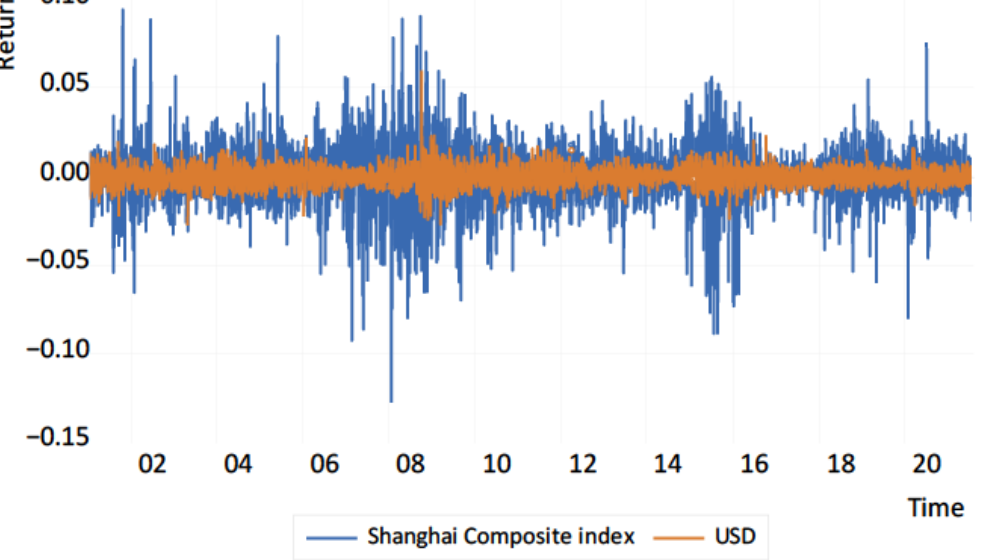
Figure 3. Log returns of SHCI and US dollar from January 2001 to July 2021.